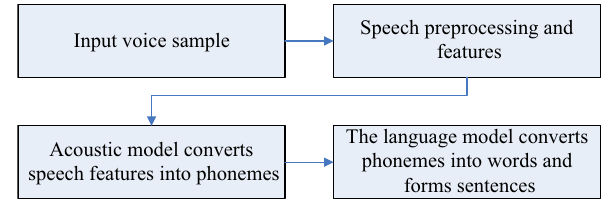
Figure 1: Traditional English speech recognition